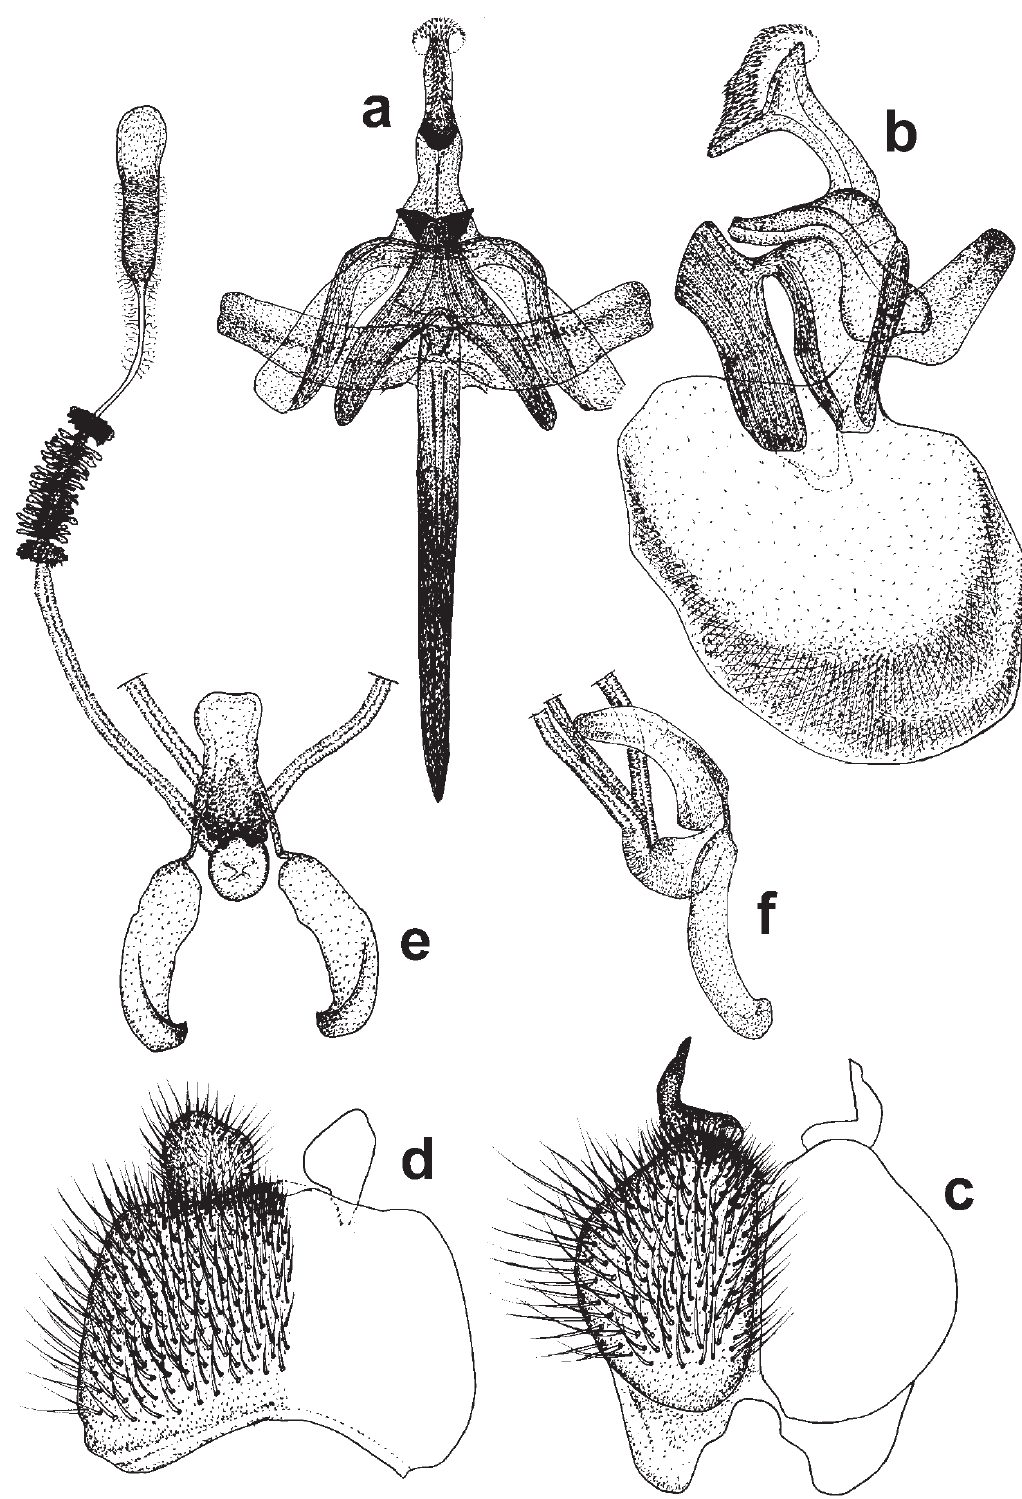
Fig. 61. Parusia aurata (Fabricius, 1794) gen. et comb. nov. a . Epiphallic complex ventral. b . Epiphallic complex lateral. c . Gonocoxite ventral. d . Epandrium dorsal. e . Female genitalia ventral. f . Female genitalia